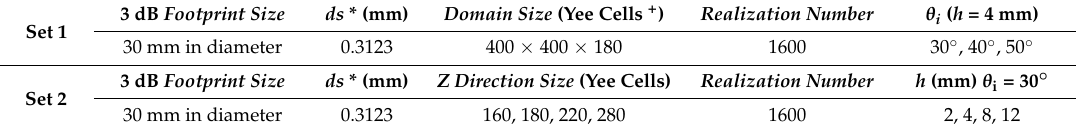
Table 3. Computational parameters for the FDTD simulations @32